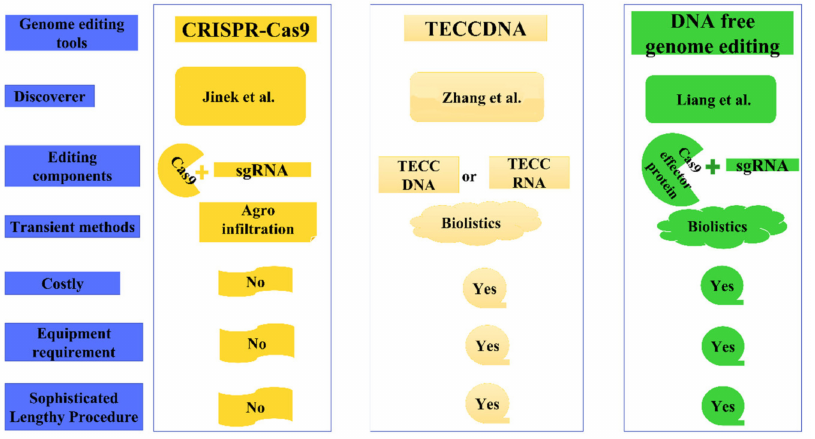
Figure 2. Genetic transformation methods in plants